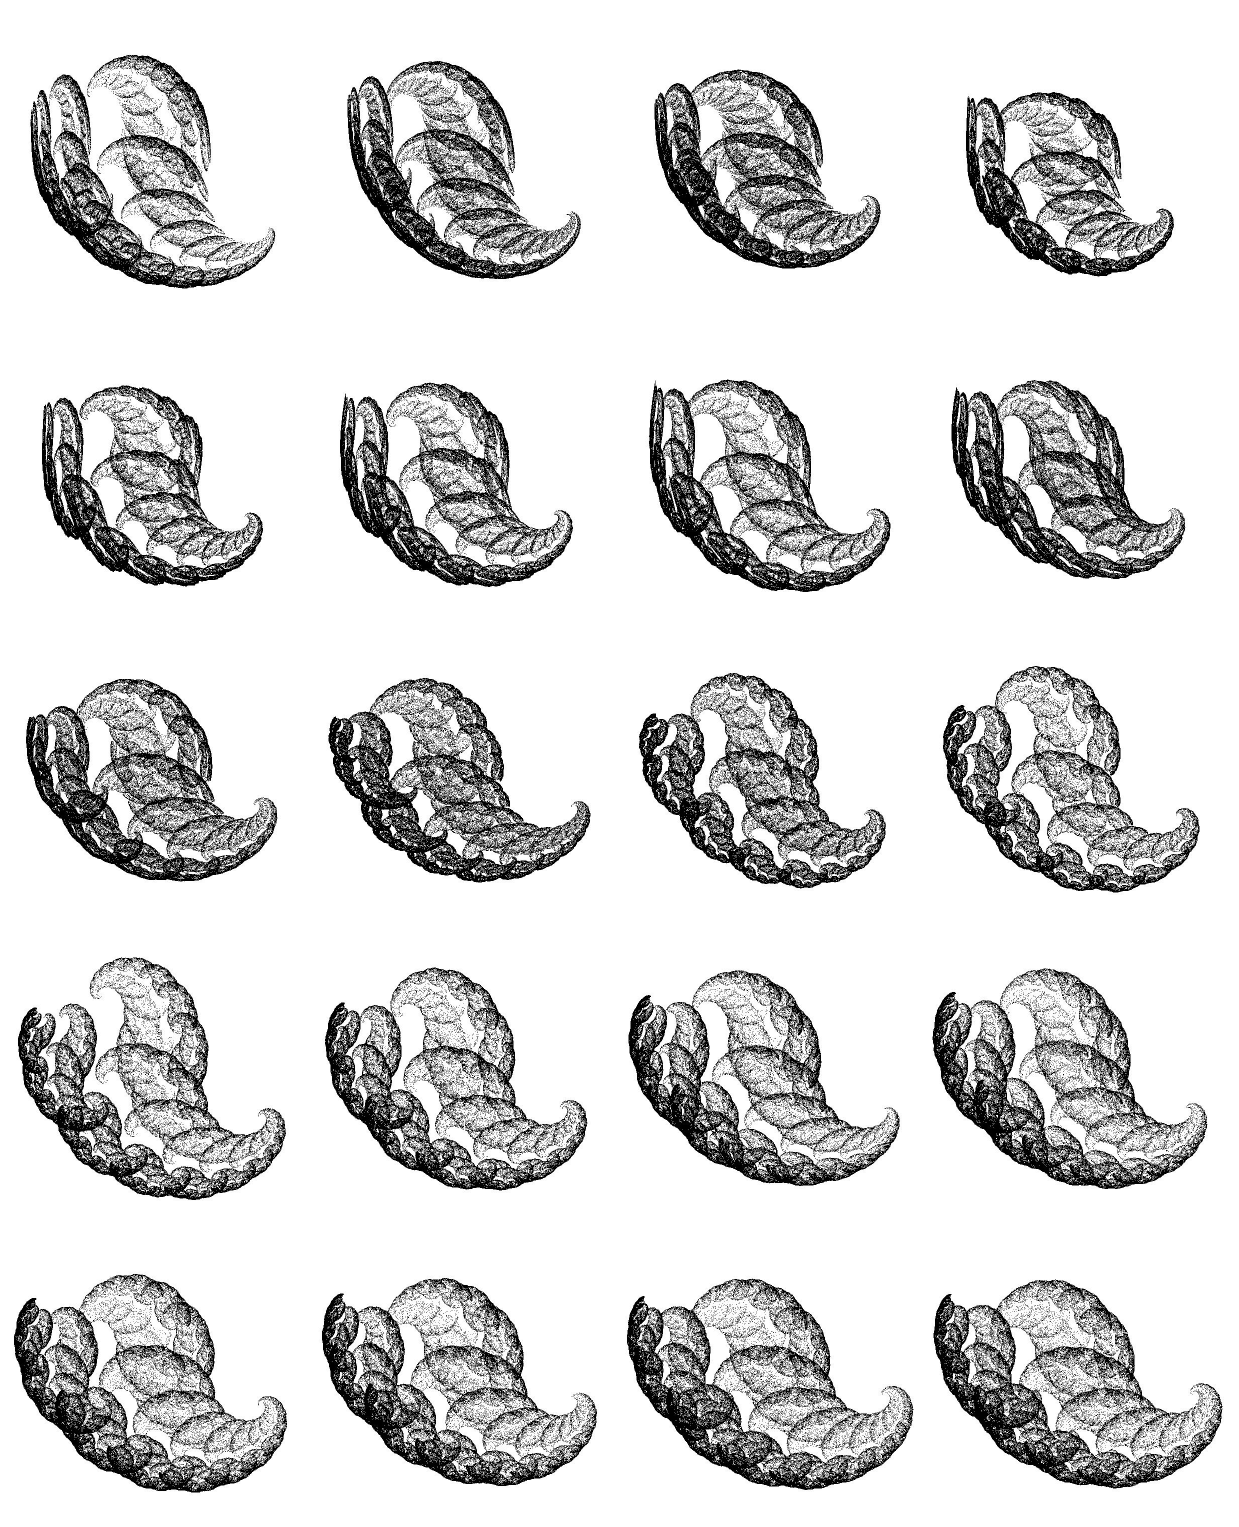
Figure 6. ( left – right , top – bottom ): Evolution of the reconstructed image for 800–1180 iterations (step size, 20